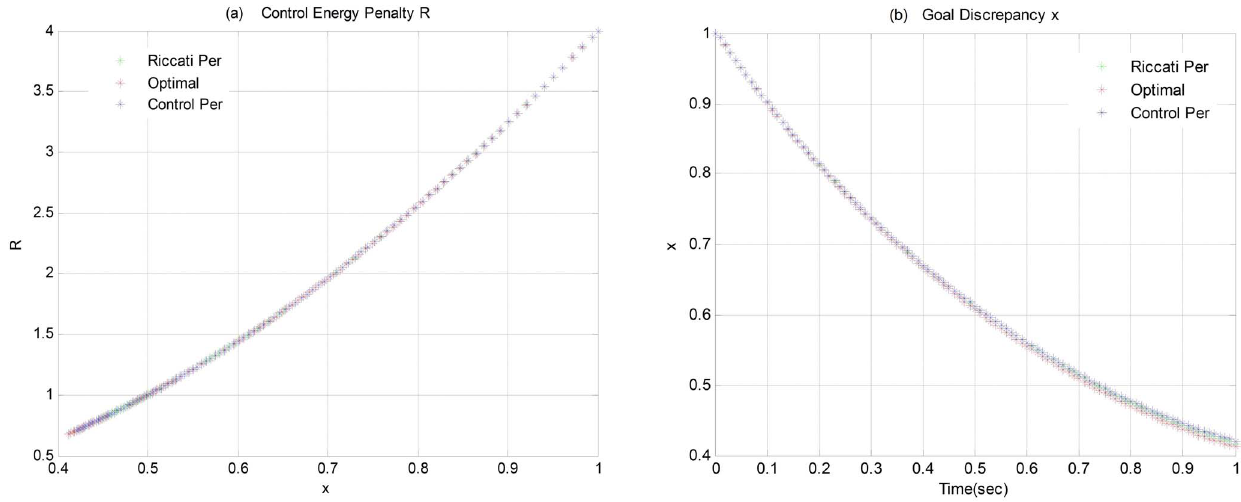
Table 2. The Values of Parameters in Simulation Case 02.